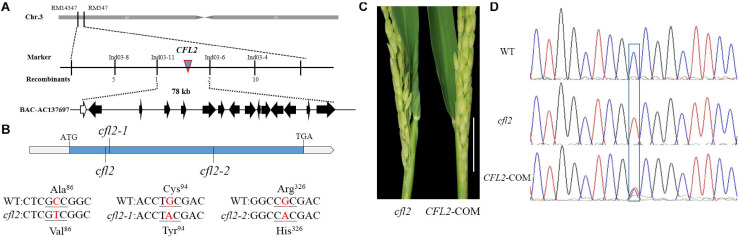
Map-based cloning of CFL2. (A) The CFL2 gene was fine mapped to the long arm of chromosome 3 between Ind03-11 and Ind03-6 with a physical interval 78 kb. (B) Gene structure of CFL2 and the mutation sites in cfl2 and its allelic mutant cfl2-1 and cfl2-2.
(C) The base of the flag leaf morphology of the cfl2 mutant and complemented transgenic plant (CFL2-COM). Scale bar = 5 cm. (D) Sequence peak chromatograms of the mutation region in plants of the WT, cfl2, and CFL2-COM.